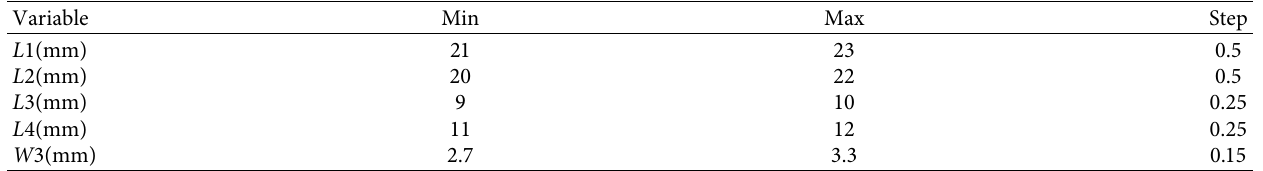
Table 8: Experimental samples of the PDA.